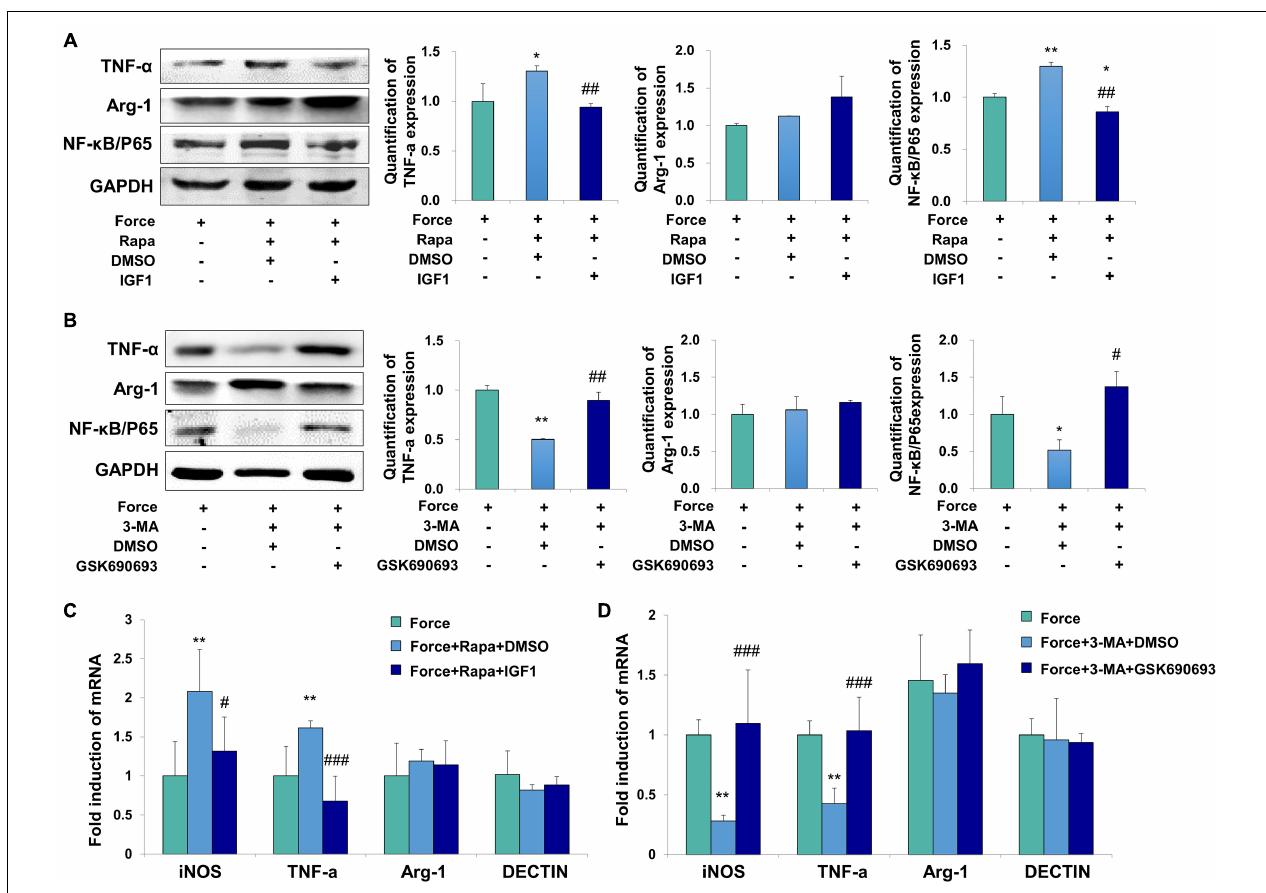
FIGURE 5 | Force induced autophagy in PDLSCs modulates M1 macrophage polarization through AKT signaling. (A) Western blot of the expressions of TNF- α , Arg-1 and NF- κ B/P65 by the application of force-loaded supernatant (FS) with rapamycin. AKT signaling activator IGF1 or equal volume of DMSO was added into supernatant. The protein levels were quantified. Results are presented as mean ± SD. n = 3. * P < 0.05, ** P < 0.01 versus the left column. ## P < 0.01 versus middle column. (B) Western blot of the expressions of TNF- α , Arg-1 and NF- κ B/P65 by the application of force-loaded supernatant (FS) with 3-MA. AKT kinase inhibitor GSK690693 or equal volume of DMSO was added into conditioned medium. Results are presented as mean ± SD. n = 3. * P < 0.05, ** P < 0.01 versus the left column. # P < 0.05, ## P < 0.01 versus middle column. (C) Relative mRNA expression of M1/M2-related genes of THP-1-derived macrophages cultured with different conditions, including FS, FS + Rapa + DMSO and FS + Rapa + IGF1. (D) Relative mRNA expression of M1/M2-related genes of THP-1-derived macrophage cultured with different conditions, including FS, FS + 3 − MA + DMSO and FS + 3 − MA + GSK690693 groups. Results are presented as mean ± SD. n = 3–4. ** P < 0.01 versus left column; # P < 0.05, ### P < 0.001 versus middle